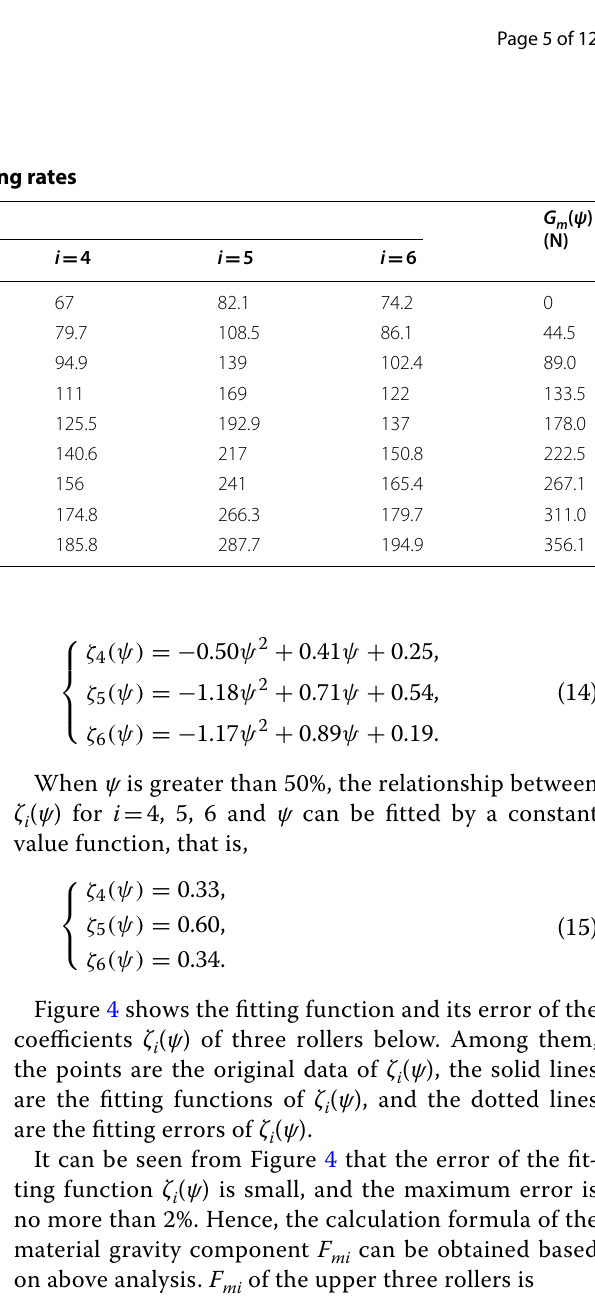
Table 2 Value of F